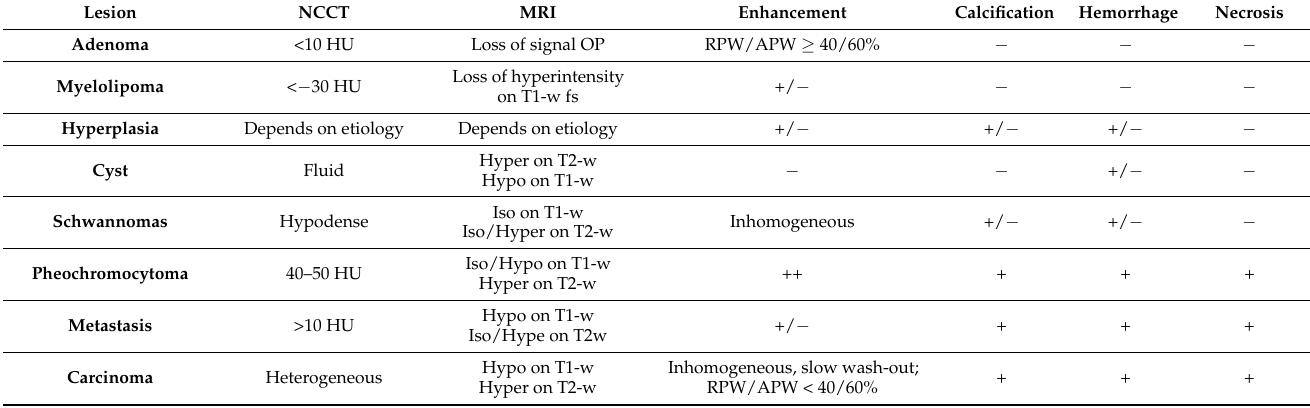
Table 1. Main imaging features of adrenal